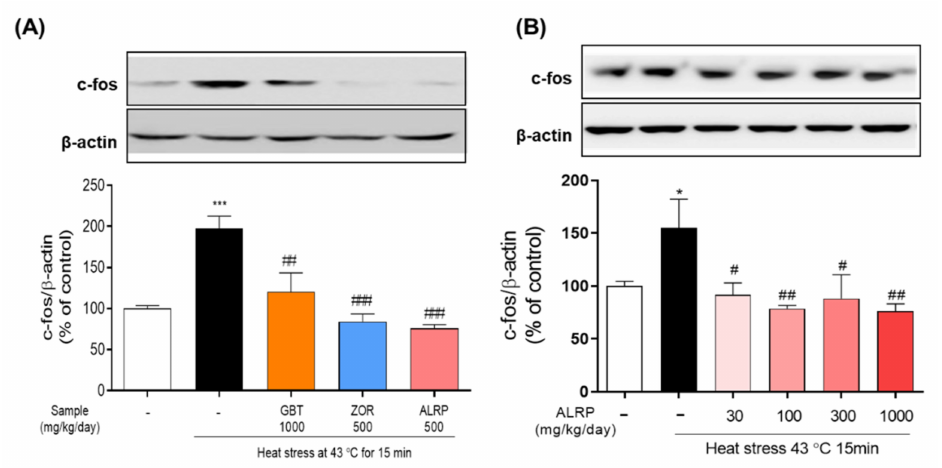
Figure 3. Suppressive effect of GBT and its constituents on heat stress-induced c-fos expression. Quantification of densitometric analyses was performed by measuring the expression ratios of c- fos/ β -actin (n = 6 per group) in the lysates of hypothalamus for investigating the effects of GBT and its ingredients, ZOR and ALRP ( A ) and ALRP in a dose-dependent manner ( B ). Values are expressed as means ± SEM. * p < 0.05 and *** p < 0.001 as compared with the control group. # p < 0.05, ## p < 0.01 and ### p < 0.001 as compared with the heat-stressed vehicle-treated group. GBT; Geongangbuja-tang decoction. ZOR; Zingiber officinale Radix. ALRP; Aconiti Lateralis Radix